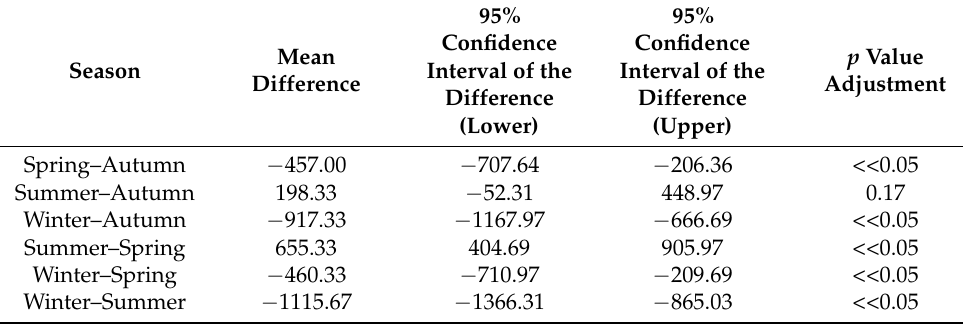
Table 4. Results of Tukey multiple